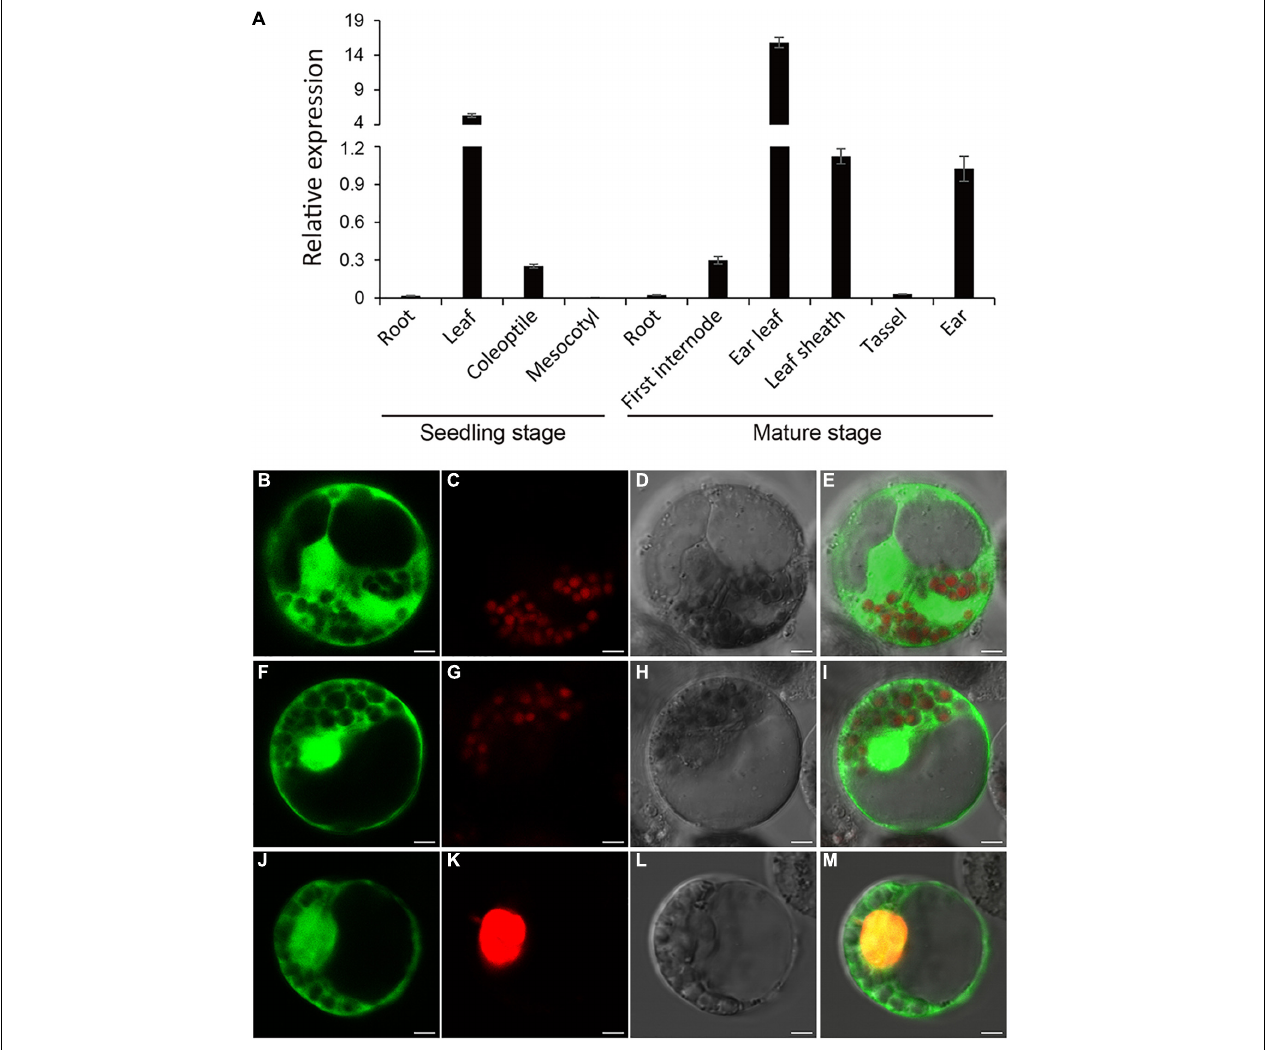
FIGURE 3 | Expression pattern and of Subcellular localization of RppM. (A) Expression analysis of RppM in Jing2416K roots, leaves, coleoptiles, and mesocotyls at the seedling stage and roots, first internodes, leaf sheaths, tassels, and ears at the mature stage was performed by quantitative real-time PCR. Data are means ± SD of three biological replicates. (B–E) The free GFP. (F–M) Subcellular localization of RppM protein in maize protoplasts. (F,J) RppM-GFP fusion protein. (C,G) Chloroplast autofluorenscence. (K) The nucleus marker D53-mCherry. (D,H,L) Bright field image. (E) Merged image of (B,C) . (I) Merged image of (F,G) . (M) Merged image of (F,G) . Scale bar: 5 µ